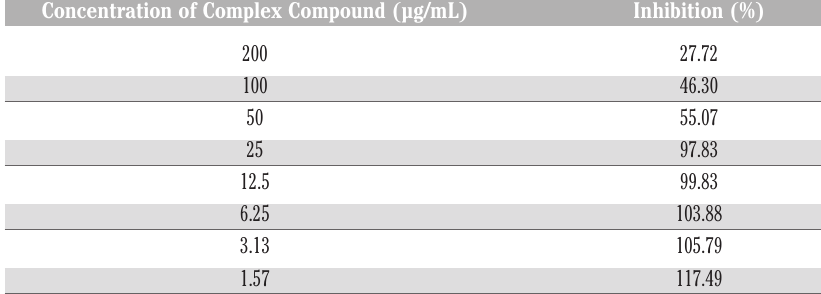
Table 2. Inhibited DENV-2 treatment with [Cu(2,4,5-triphenyl-1 H -imidazole) 2 (H 2 O) 2 ].Cl 2. Concentration of Complex Compound (µg/mL)